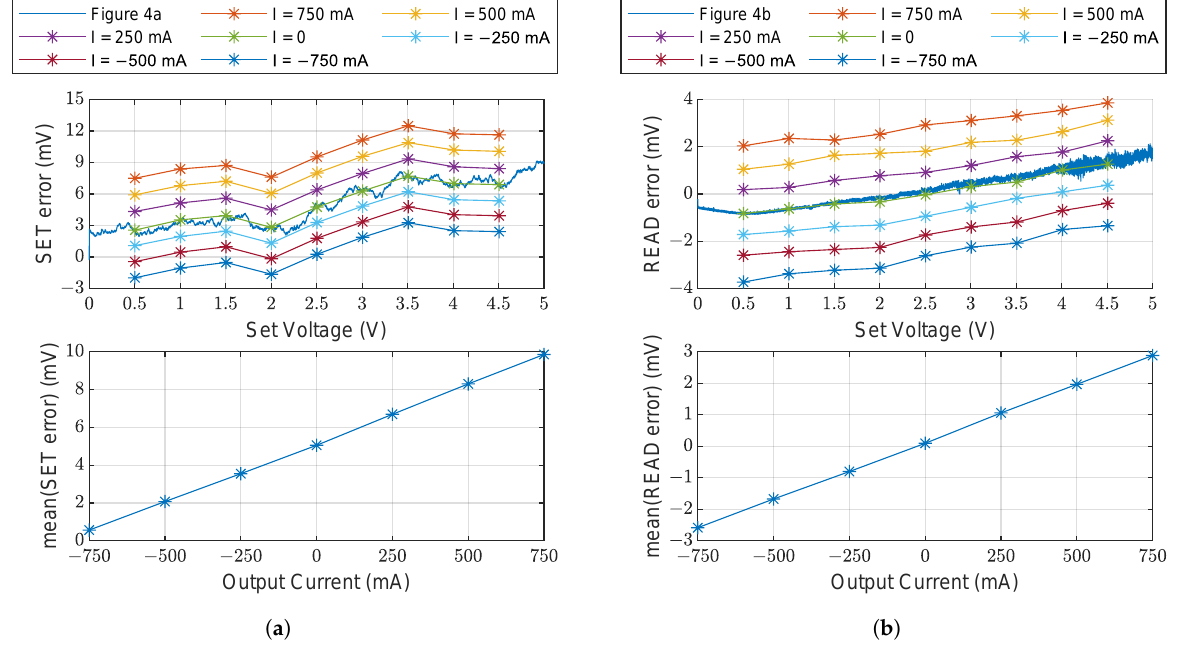
Figure 7. Set voltage error ( a ) and read voltage error ( b ) with different cell current values. Errors versus the set value ( top ). Mean set and read errors as a function of the output current ( bottom